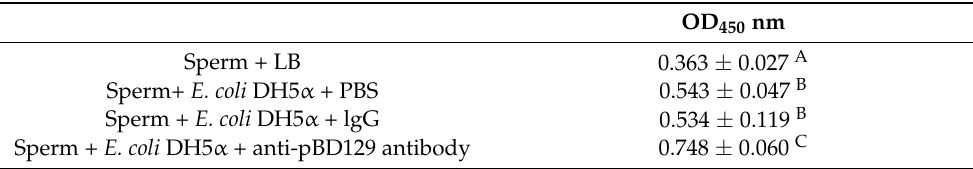
Table 3. The effect of pBD129 on the proliferation of E. coli DH5 α